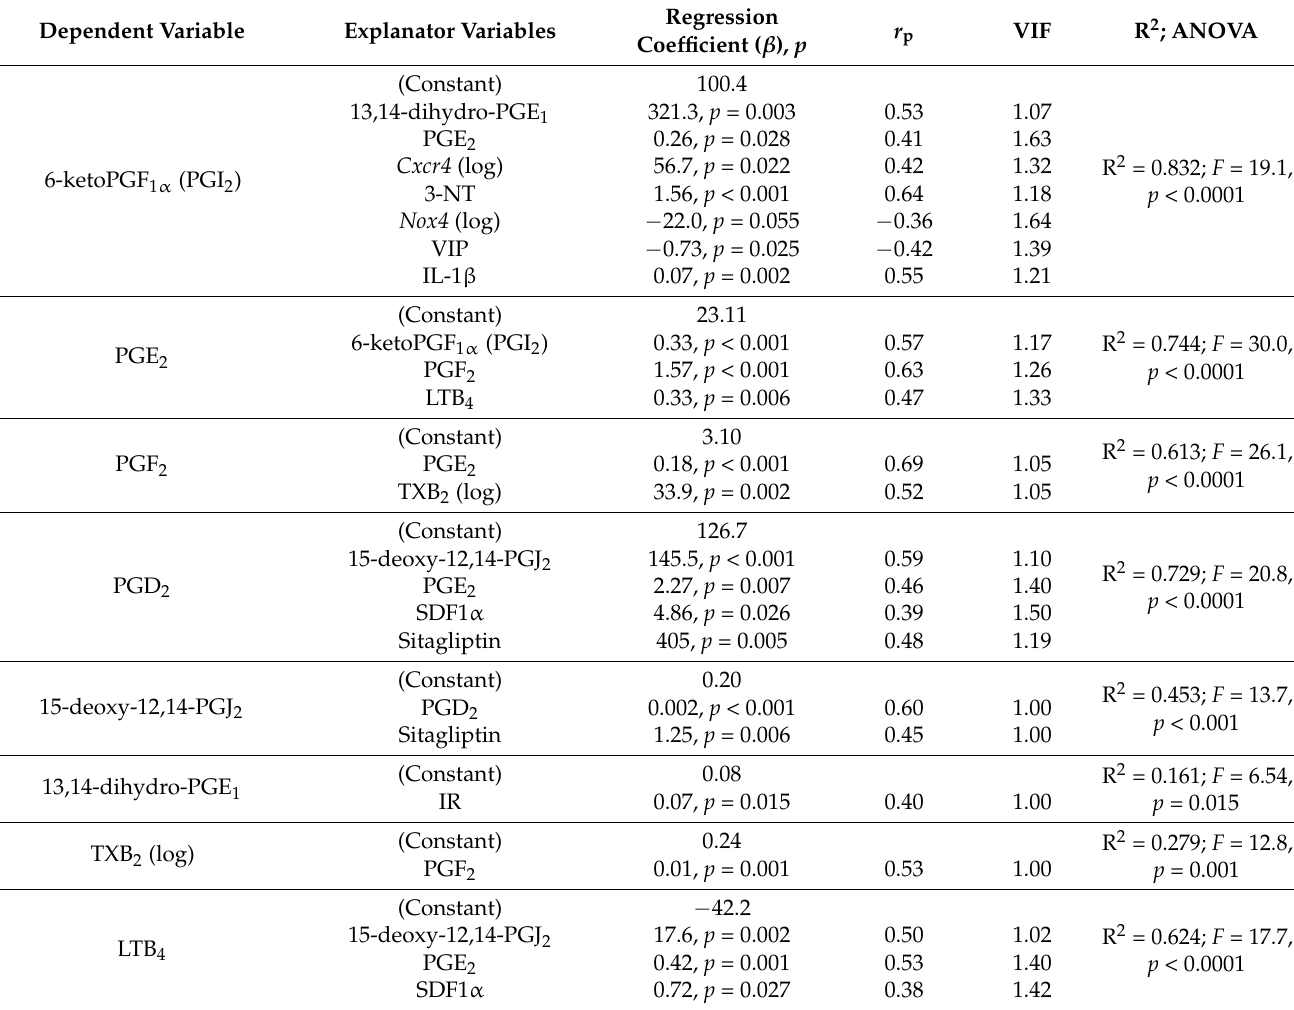
Table 2. Regression models explaining variability in the liver concentration of